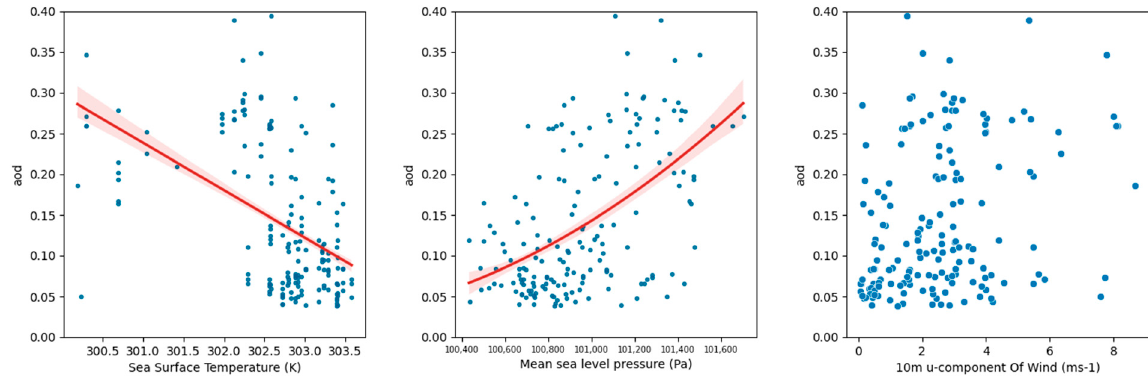
Figure 9. AOD-meteorological relation in spring.